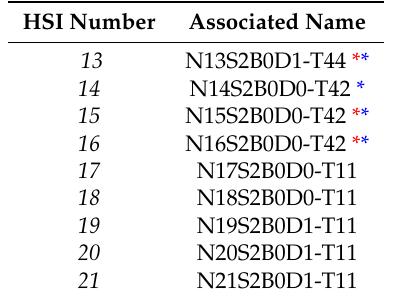
Table 3. Names are coded using the pattern N·S·B·D·-T· where S identifies the setup (2), B the background (black, white), D the position of the gray-scale rows (toward center or toward border) and T the integration time. The star points at the images which presents saturated white in the A ColorChecker (red) and in the B ColorChecker (blue).